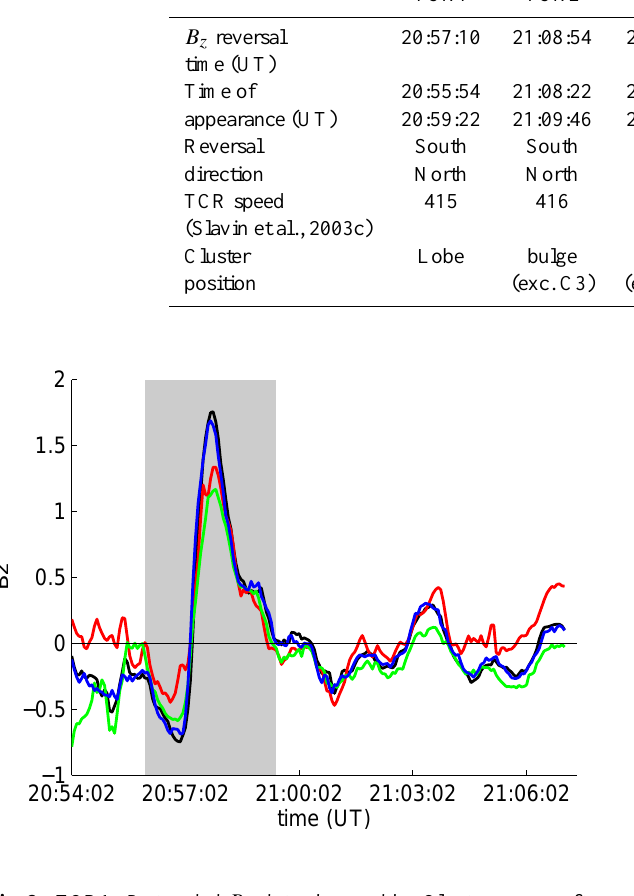
Table 1. Overview of the TCRs on 19 September 2001. The reversal time corresponds to the change of sign in B z . The time of appearance displays the time interval between the onset and the offset of the disturbance in B z . The speed of the TCR was determined by Slavin et al. (2003c) via time of flight (TOF) calculations by using lag correlations in magnetic field measurements between s/c 1 and 4, which had the largest separation. Therefore, the difference in the pass-by time of the TCRs at s/c 1 and 4 can been taken to determine the speed of the TCRs. Except C3, all Cluster s/c were swept over by the plasma bulge during the second and third TCR. TCR1 TCR2 TCR3 TCR4 TCR5 B z reversal